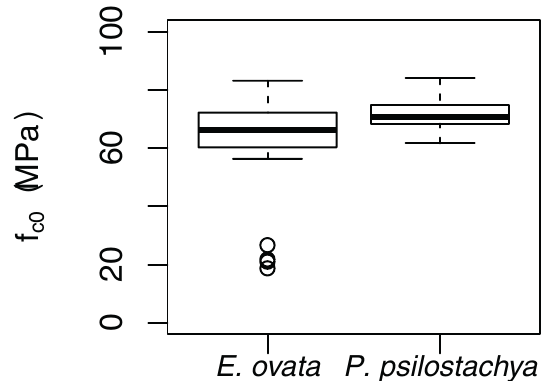
Figure 1 - Data distribution of resistance to parallel compression emphasizing the outliers on E. ovata